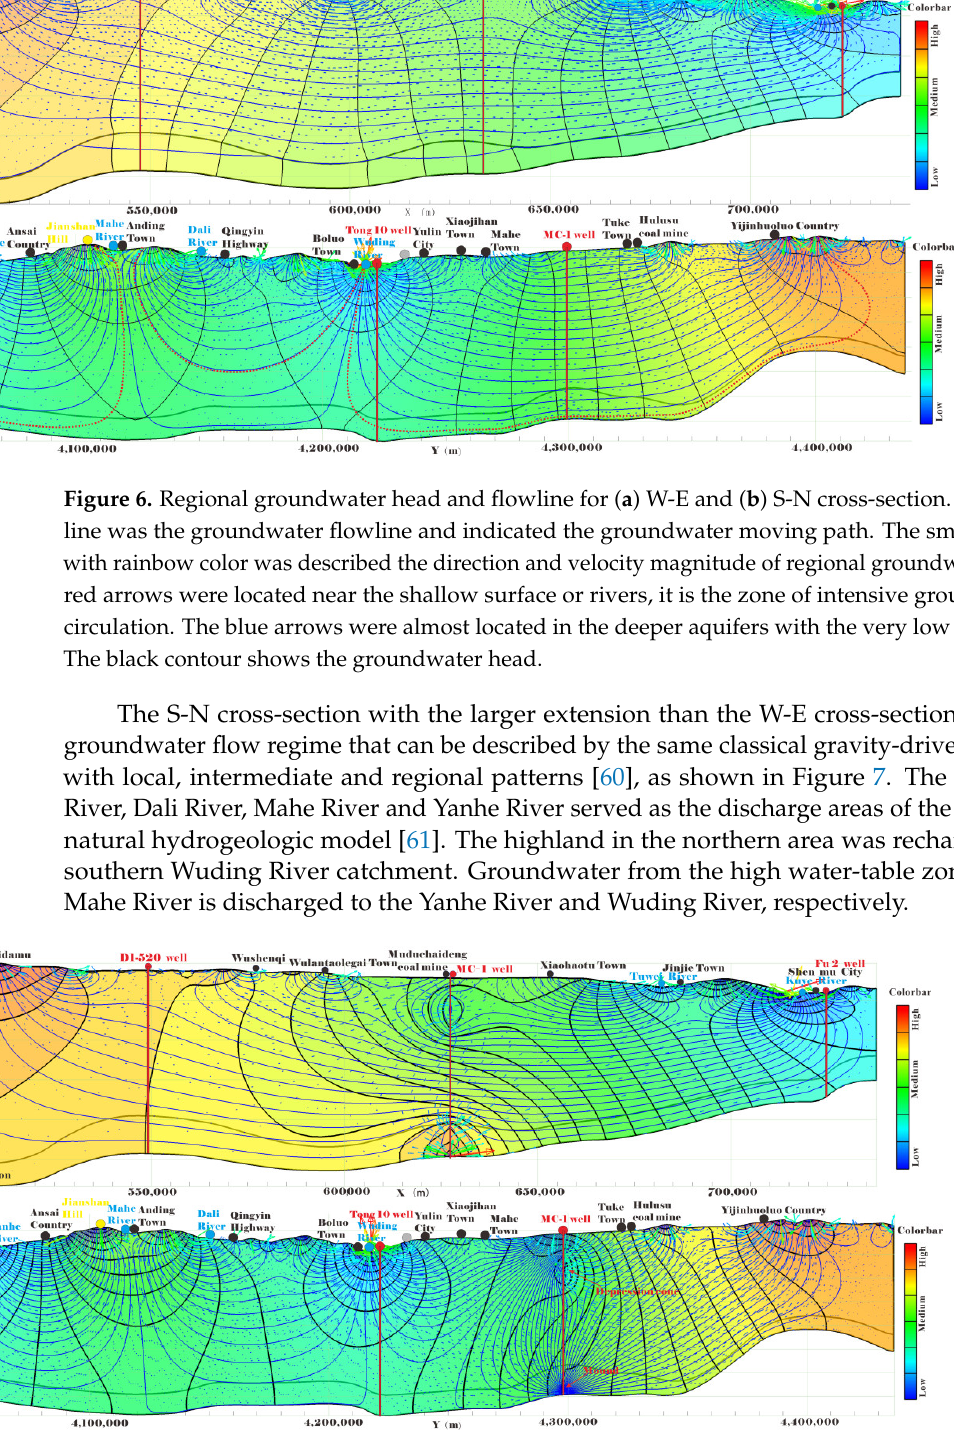
Figure 7. Regional groundwater head and flowline change induced by mine water injection activity through the MC-1 well for ( a ) W-E and ( b ) S-N cross section. Mine water drainage in shallow aquifers and water injection activities in deeper strata around the MC-1 well were simulated to manifest their effect on the regional circulation of